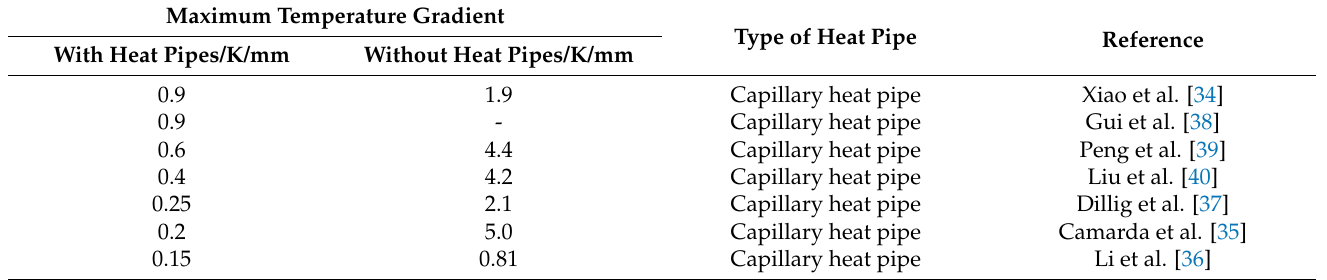
Table 2. Characteristics of heat pipes for isothermal performance in thermal